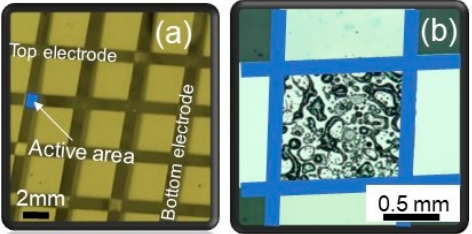
Figure 2. Optical microscope image of ( a ) crossbar type array consisting of devices with active area of 1 mm × 1 mm, ( b ) optical microscope image of a single 1 mm × 1 mm device.